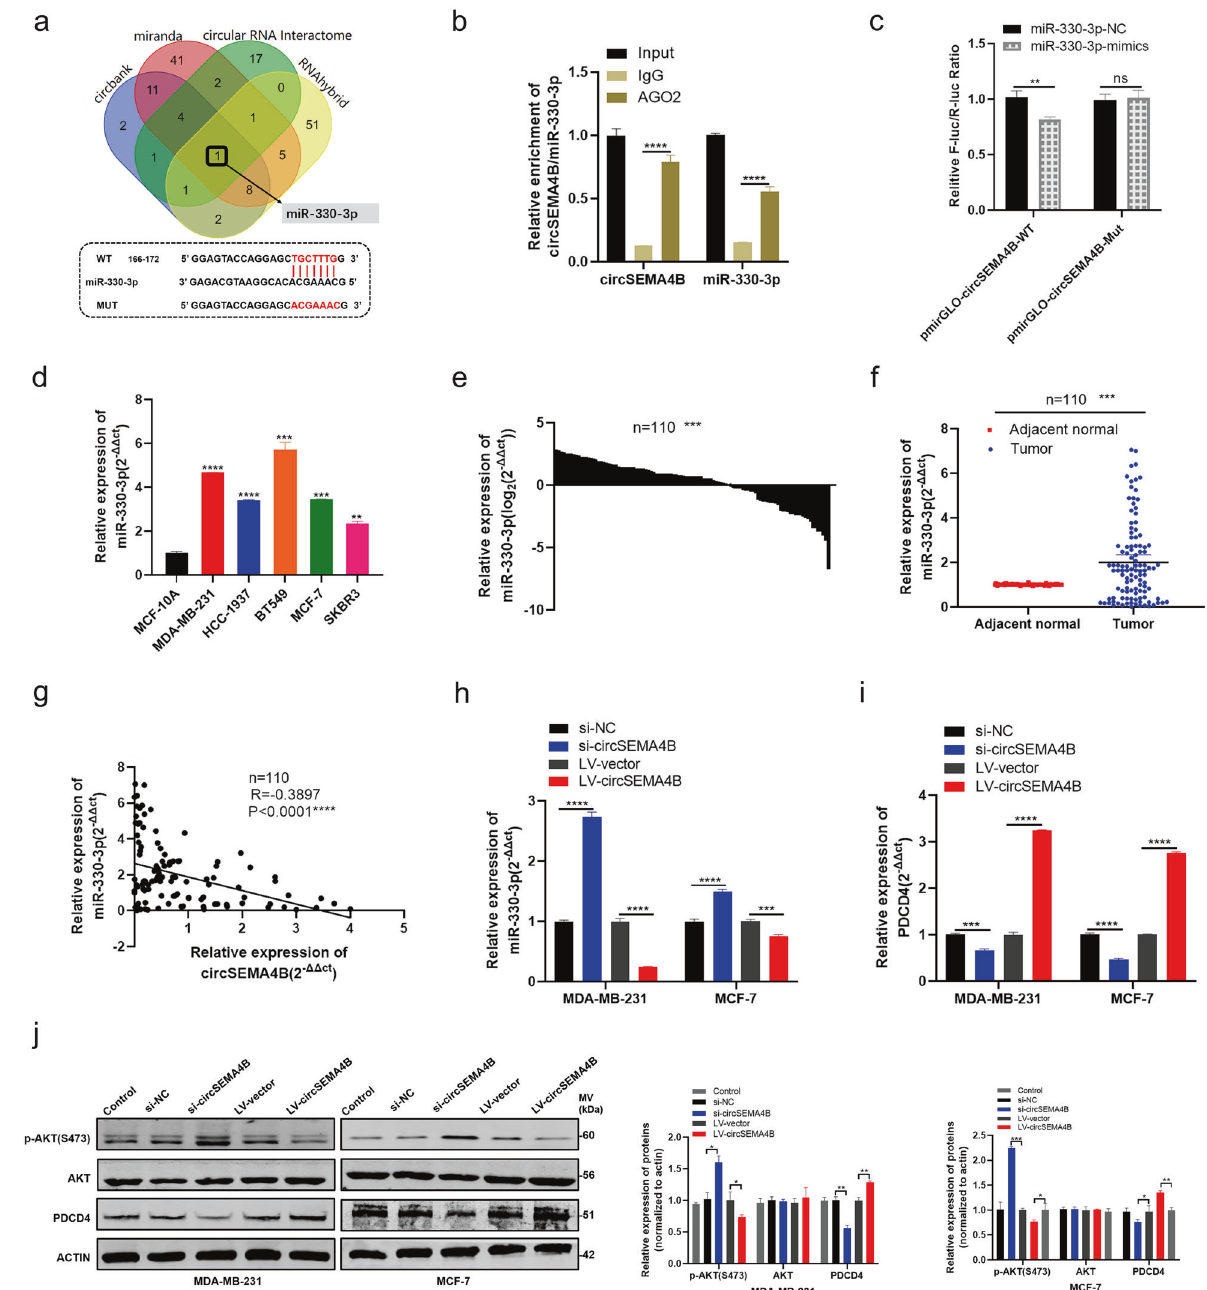
Fig. 6 CircSEMA4B serves as a sponge for miR-330-3p. a Upper panel, Venn diagram showing the potential target miRNAs of circSEMA4B. Lower panel, Putative complementary sites within miR-330-3p and circSEMA4B predicted by bioinformatics analysis. b RIP experiments were performed in HEK293T cells, and the co-precipitated RNA was subjected to qRT-PCR for miR-330-3p and circSEMA4B. c Dual-luciferase reporter assays demonstrated that miR-330-3p is a direct target of circSEMA4B. d miR-330-3p had high expression in BC cell lines compared with MCF- 10A. e , f miR-330-3p had high expression in BC tissues compared with adjacent normal tissues. g Correlations between the expression of circSEMA4B and miR-330-3p were found with Pearson ’ s correlation analysis in BC tissue samples ( n = 110). h Expression of miR-330-3p in BC cells transfected with si-circSEMA4B or LV-circSEMA4B. i Expression of PDCD4 in BC cells transfected with si-circSEMA4B or LV-circSEMA4B. j The protein levels of PDCD4 and AKT/p-AKT(S473) in BC cells transfected with si-circSEMA4B or